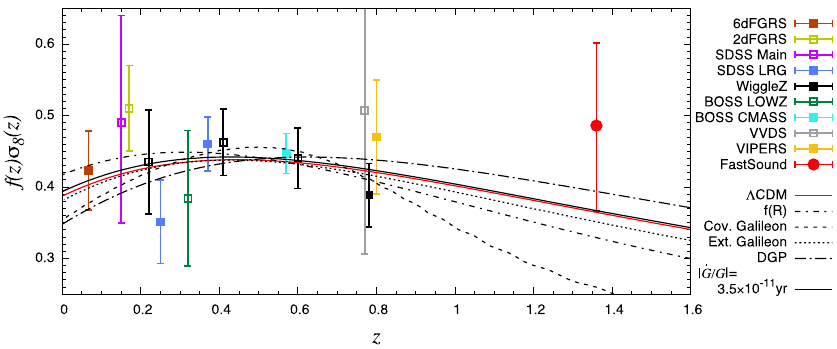
Fig. 3 Growth rate f ( z )σ 8 ( z ) measurements for redshift range 0 < z < 1 . 55 and theoretical predic- tions from standard GR- Λ CDM model and MG models f ( R ) (see Sect.7.4.1), covariant Galileons (see Sect. 7.3.1), extended Galileons, DGP (see Sect. 7.5.2), and models with varying gravitational constant. TheconstraintobtainedfromSubaruFastSoundsampleat1 . 19 < z < 1 . 55(Okumuraetal.2016)isplotted asthebigredpoint.Theotherresultsincludethe6dFGS,2dFGRS,SDSSmaingalaxies,SDSSLRG,BOSS LOWZ , WiggleZ, BOSS CMASS, VVDS, and VIPERS surveys at z < 1. Predicted f σ 8 from GR- Λ CDM with the amplitude determined by minimizing their χ 2 is shown as the red solid line. The data points used for the χ 2 minimization are denoted as the filled-symbol points. The other curves are predictions from MG models as indicated on the right. Image reproduced with permission from Okumura et al. (2016), copyright by the